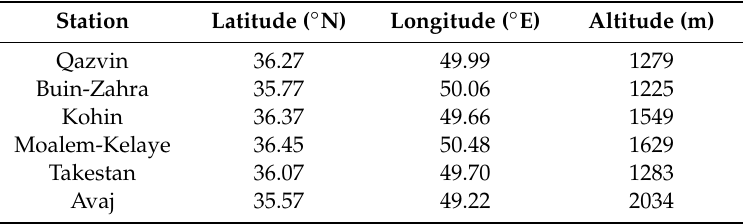
Table 1. Coordinates of the meteorological stations of the study area.